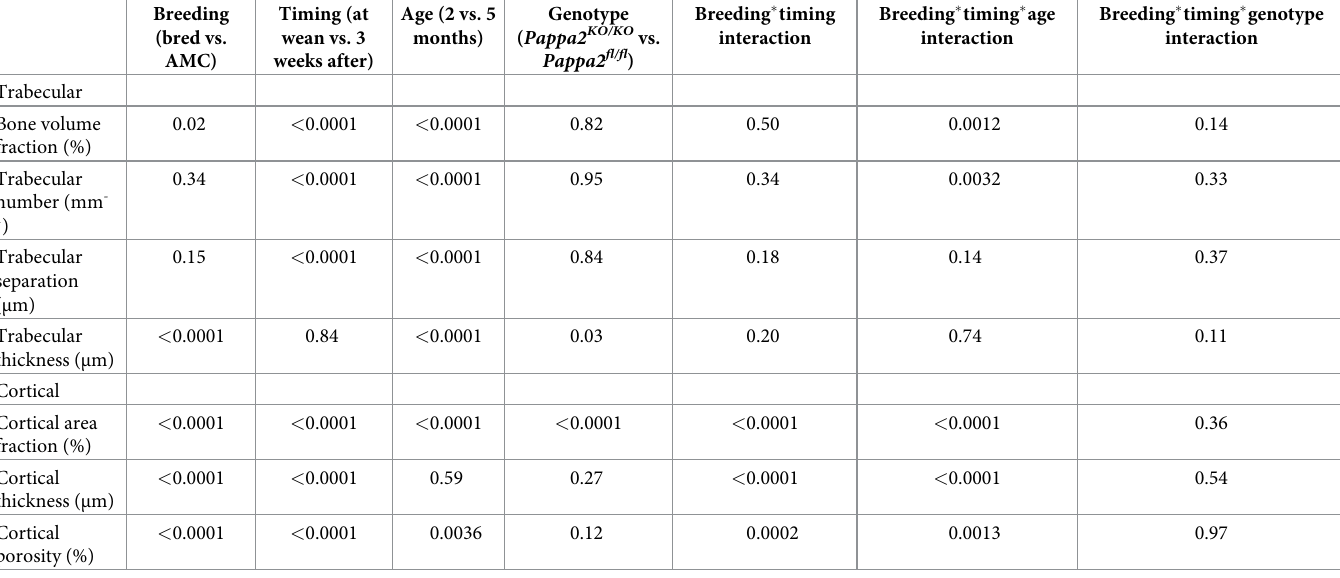
P-values are from general linear models included effects of breeding, timing, age, genotype, the interaction between breeding and timing, and three-way interactions between breeding, timing and genotype (to test whether recovery differed between genotypes) and between breeding, timing and age (to test whether recovery differed between ages). AMC = age-matched